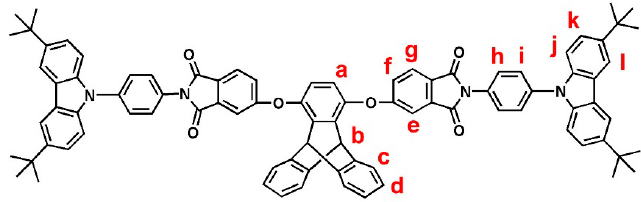
Figure 4. Structure and codes of hydrogen atoms of M2.